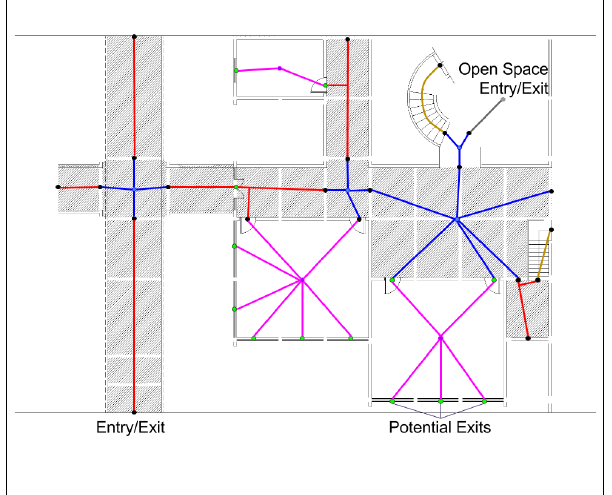
Figure 7: Network view of the ground floor of the Himalaya building